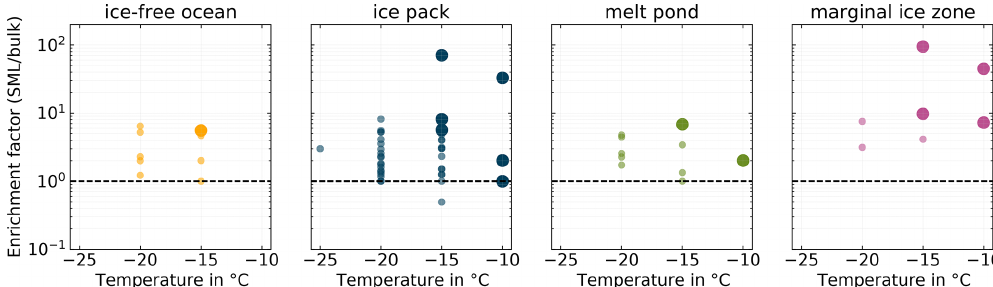
Figure 6. Enrichment factors for all pairs of SML and BSW samples (INDA measurements) divided into separate panels by their environ- mental setting. Larger markers correspond to the pairs of samples for which either the SML or the BSW sample stands out in terms of ice